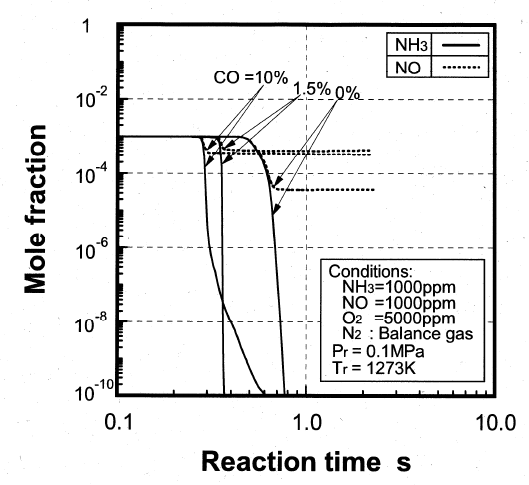
Figure 33. Mole fraction-time profiles of NH and 10%, added in the NH is 1273